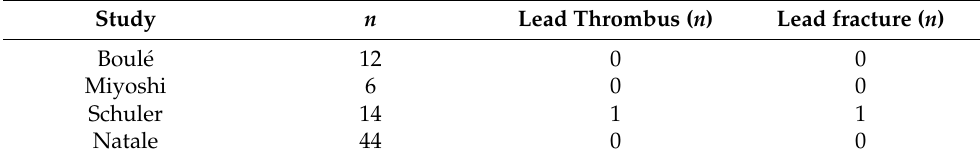
Table 8. Device-related complications.